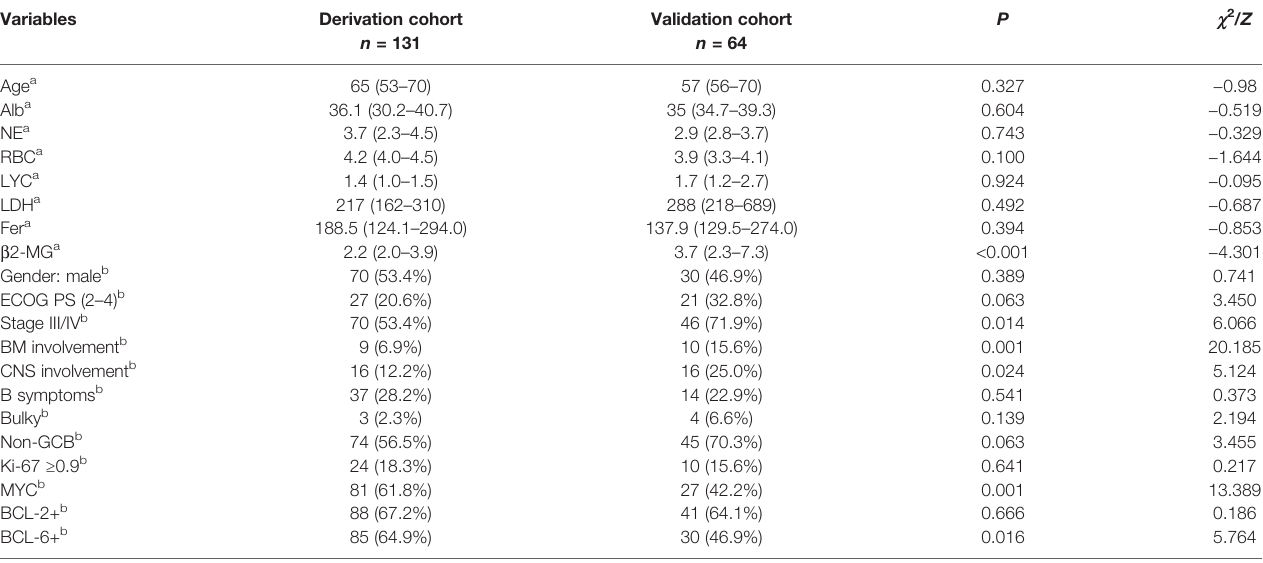
TABLE 1 | Characteristics of CD5+ DLBCL patients in the two